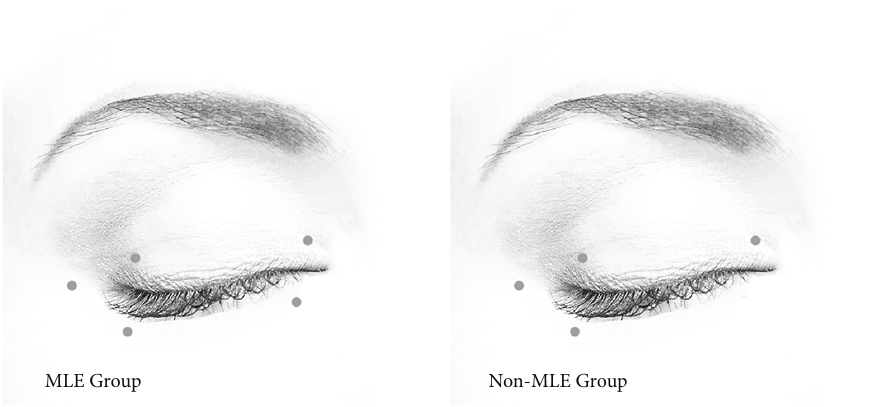
Figure 1: Injection sites in the MLE Group and the non-MLE Group for patients with